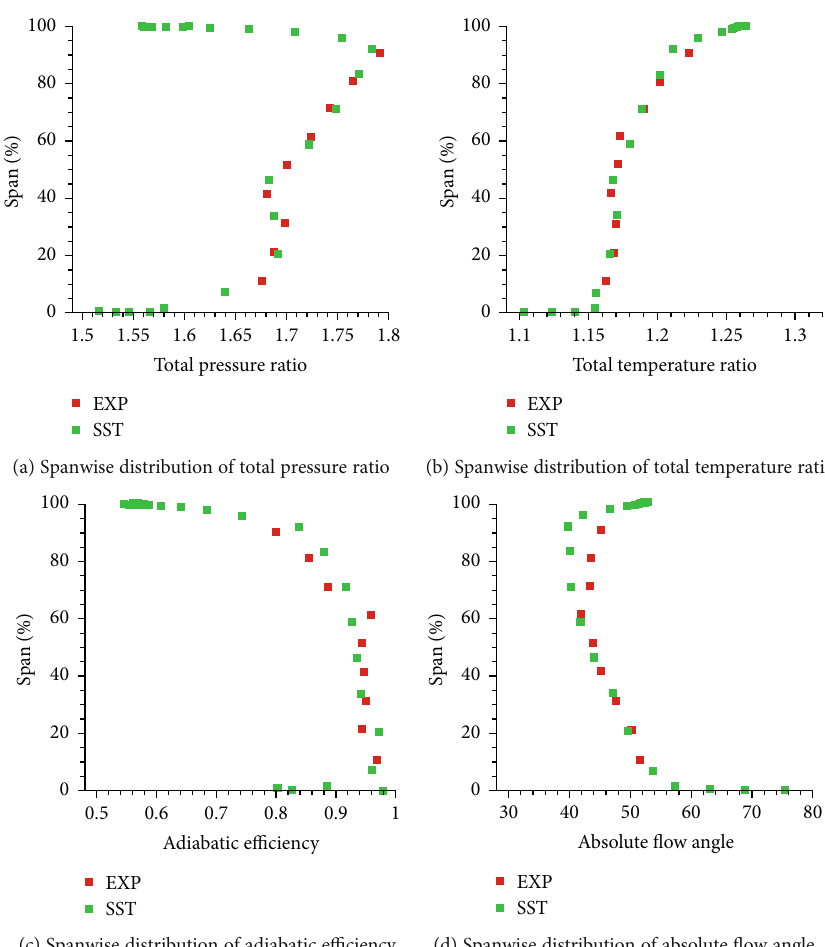
Figure 7: Computational and experimental spanwise distributions of total pressure ratio, total temperature ratio, adiabatic e ffi ciency, and absolute fl ow angle at near stall